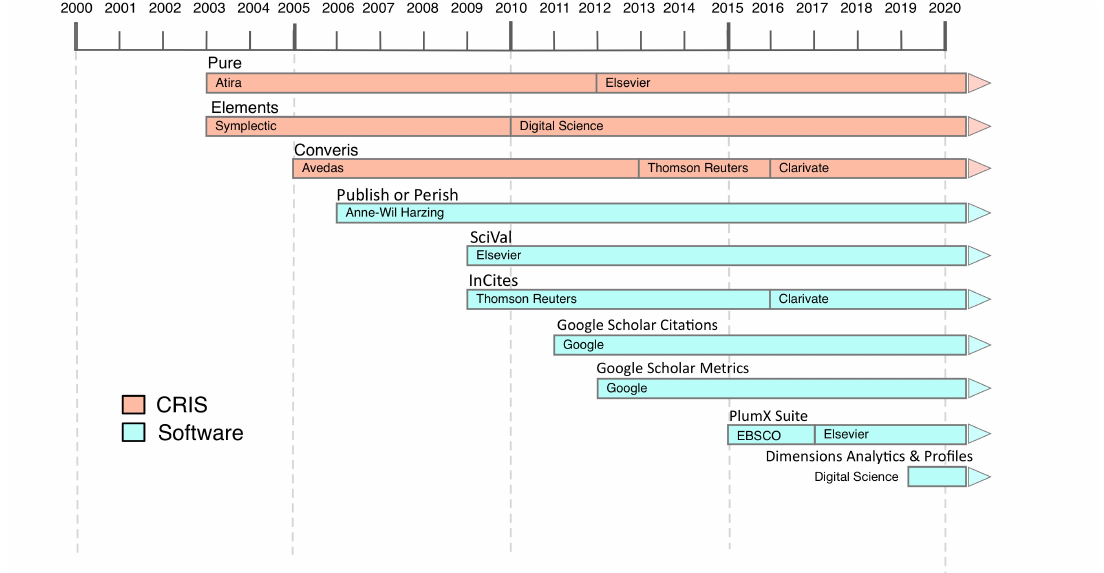
Figure 3. Development of software and current research information systems. Source: Authors’ own